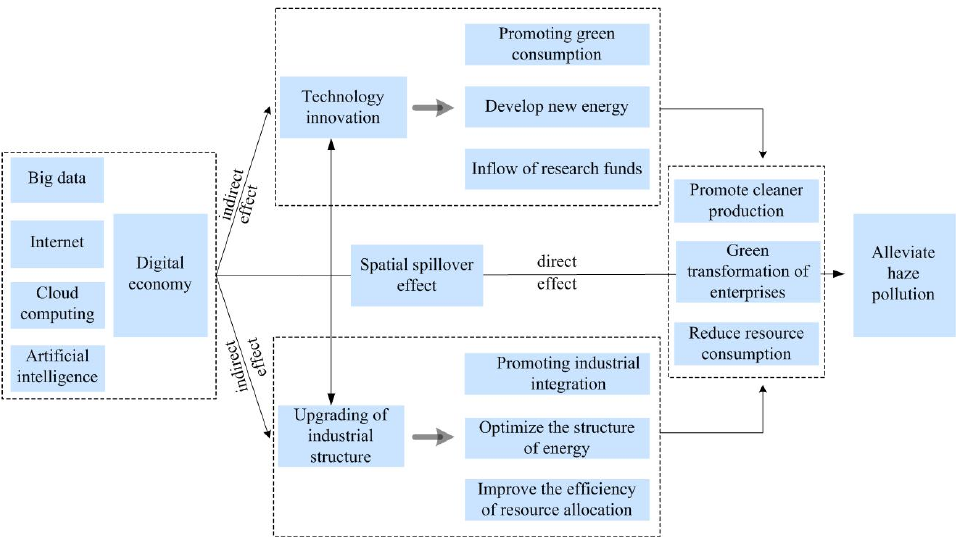
Figure 5. The mechanism of the effect of the digital economy on haze pollution.